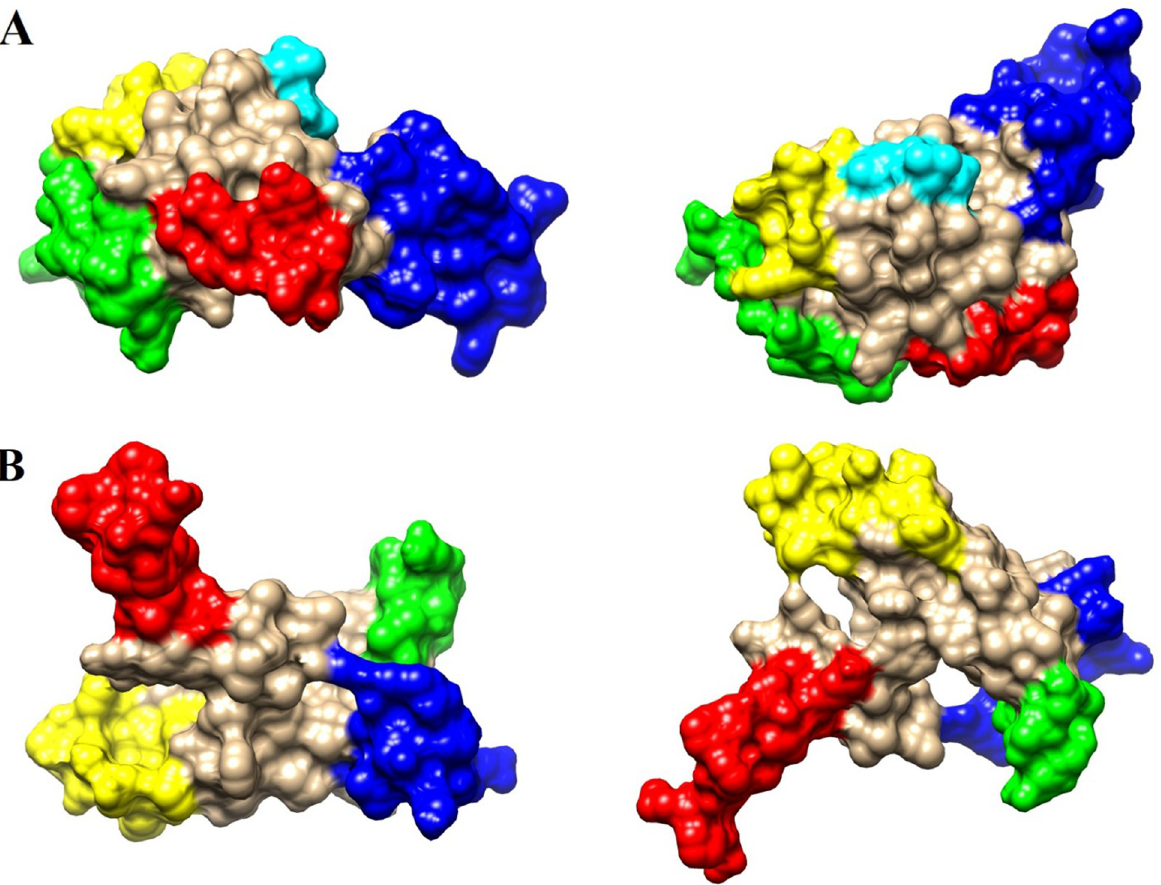
Fig 5. Conformational B-cell epitopes of A) ht-MAP2191 and B) ht-FAP-P in two different orientations, distinguished by different colors according to Table